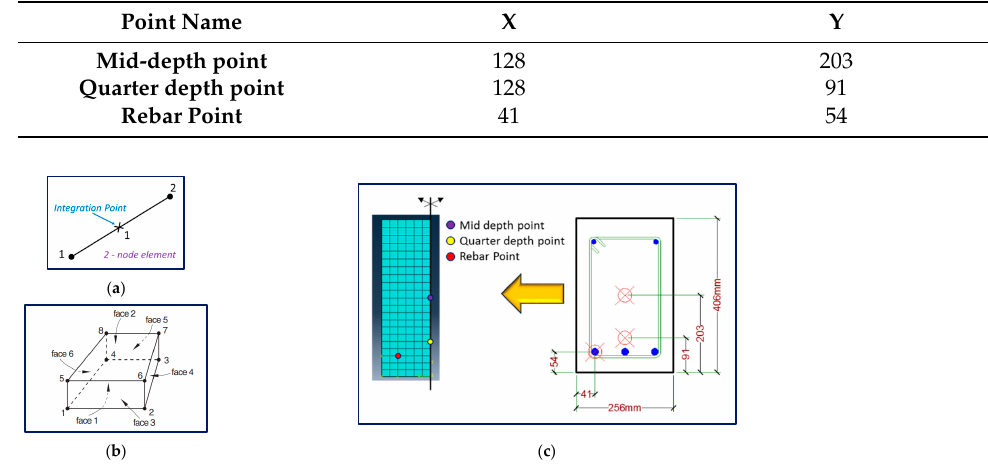
Figure 6. ( a ) T3D2T (2-node element) Direct Coupled Element [17], ( b ) C3D8T (8-node element) Direct Coupled Element [17], and ( c ) Points used for thermal validation.